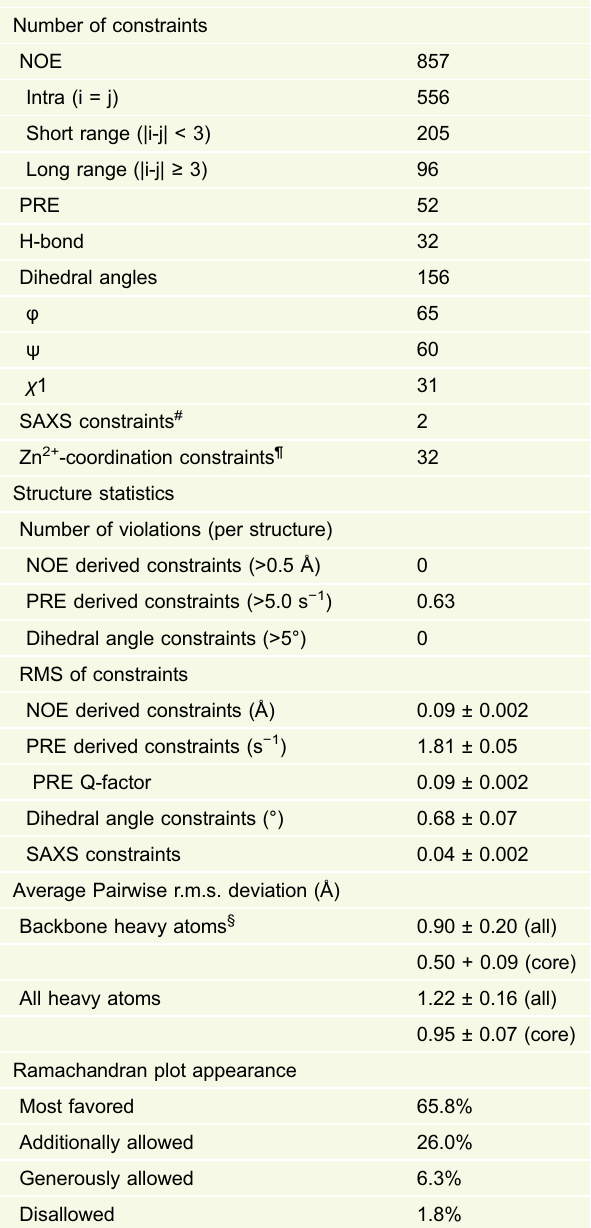
Table 1. Statistics for the solution structure of METTL3 ZFD Number of